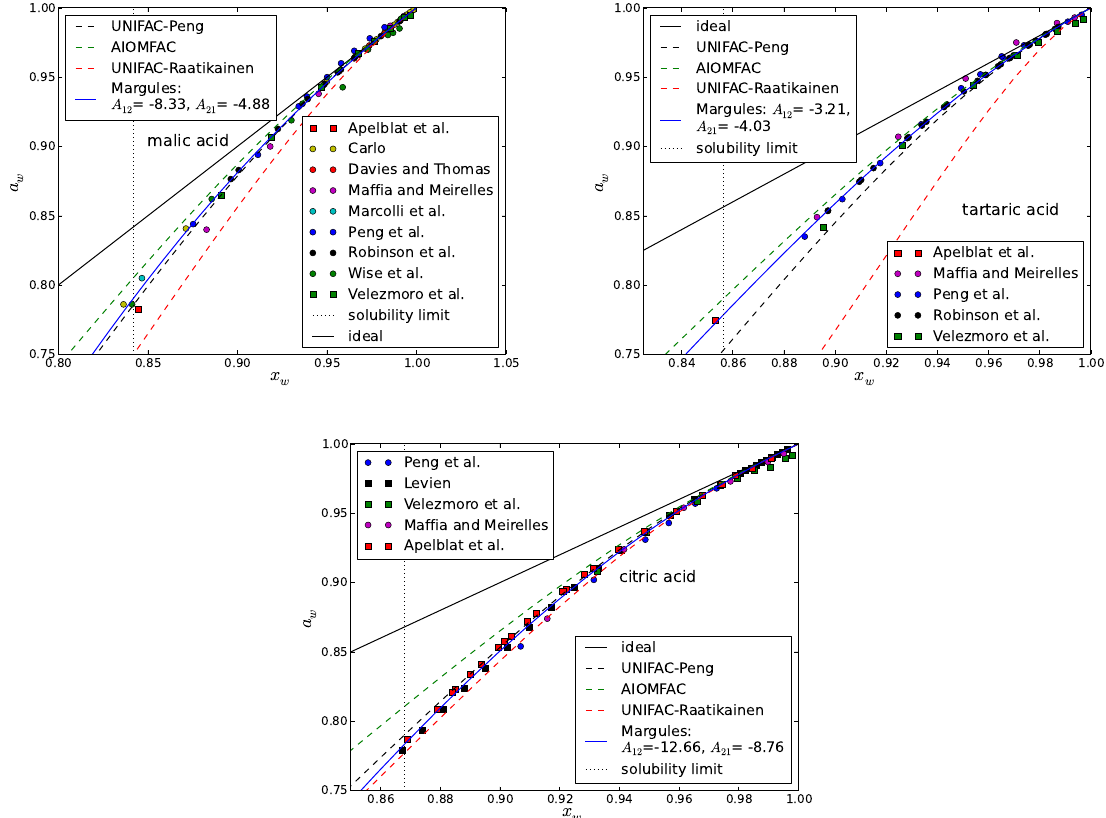
Fig. A2. Water activity of malic, tartaric and citric acids in the subsaturation region. Mixture-specific fitted expressions and group- Fig. 7. Water activity of malic, tartaric and citric acid in the subsaturation region. Mixture-specific fitted contribution activity estimations are also expressions and group-contribution activity estimations are also indicated.